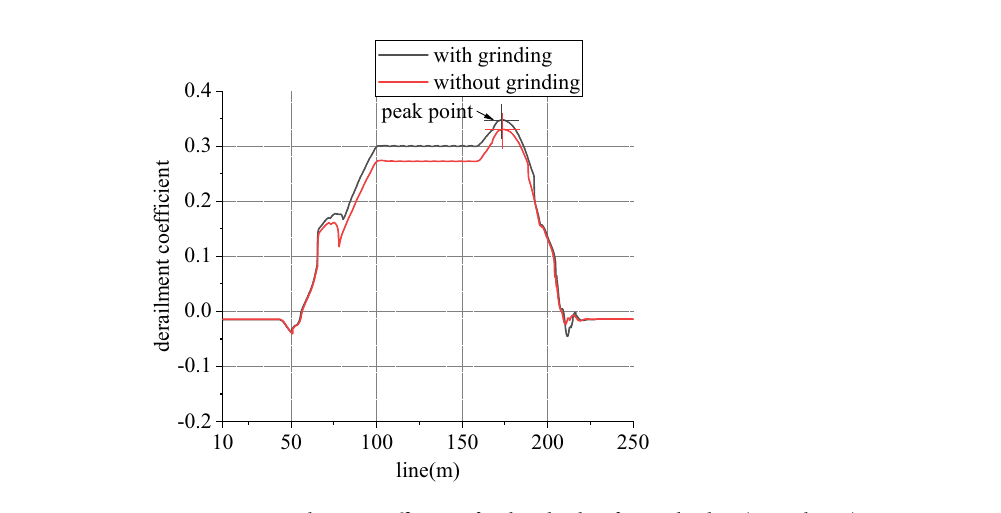
Figure 16. Derailment coefficient of right wheel in front wheelset (typical case).